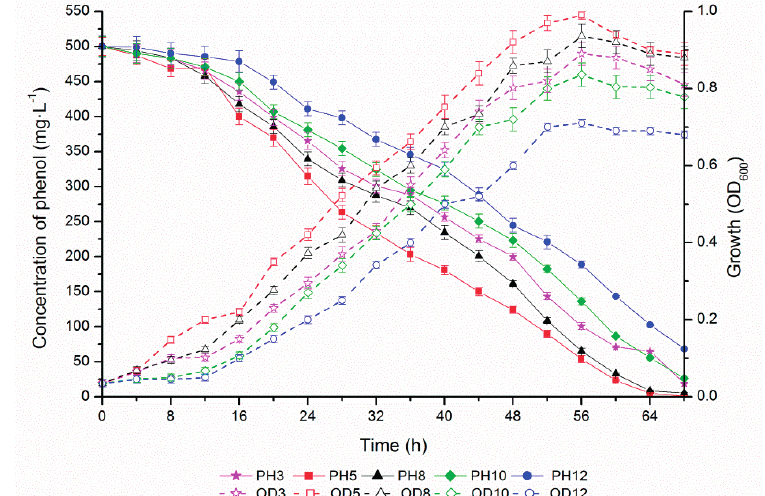
Figure 6. Biodegradation of phenol by Halomonas sp. strain 4-5 at different salt concentrations with 500 mg·L − 1 phenol. The experiments were carried out in 125-mL serum bottles containing 50 mL of mineral salts medium (MSM) with 5% inoculation. PH stands for phenol concentration, and OD stands for optical density. Numbers correspond to NaCl concentration. Data are the mean of triplicate bottles, and bars indicate ± the standard